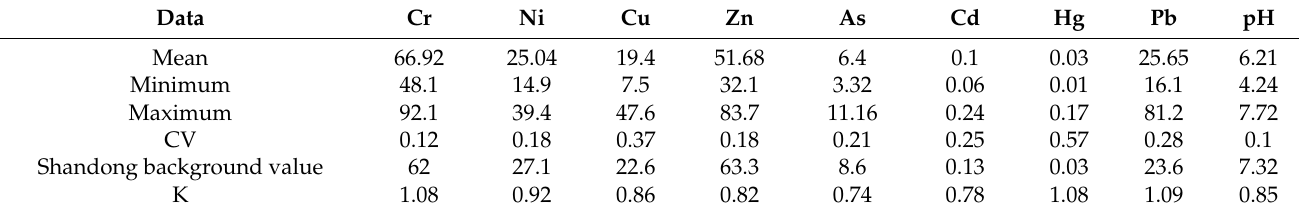
Table 2. Statistical characteristics of heavy metal contents in surface soil